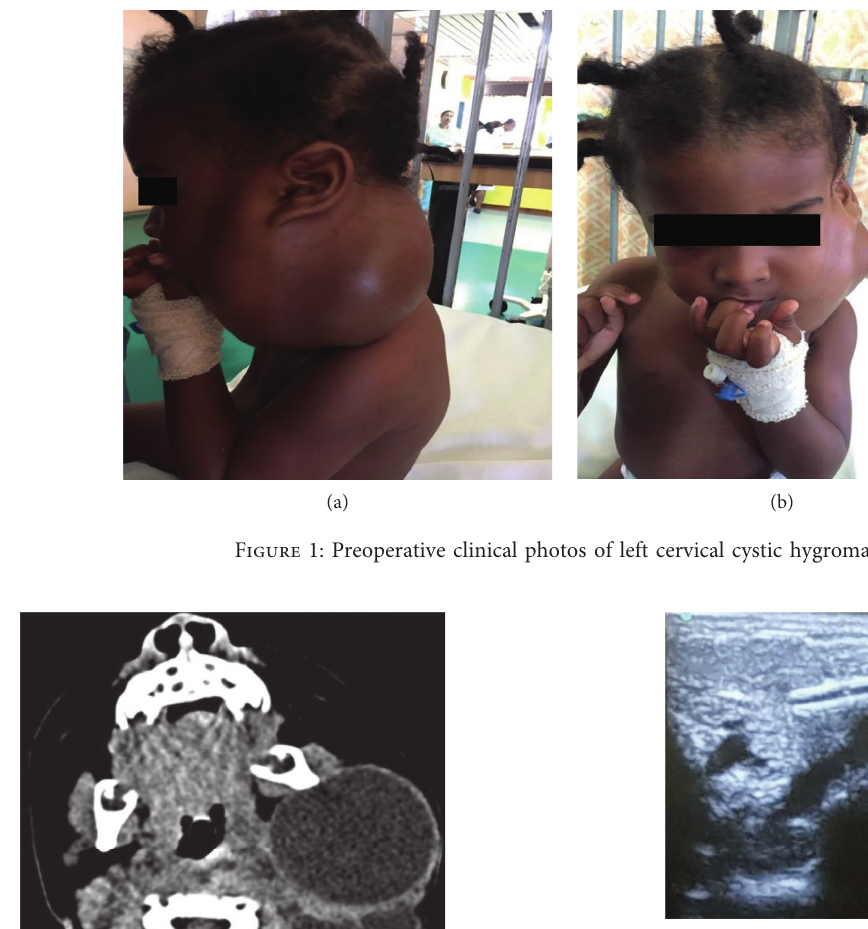
Figure 4: Cannulation of the cystic lesions using ultrasound guidance.